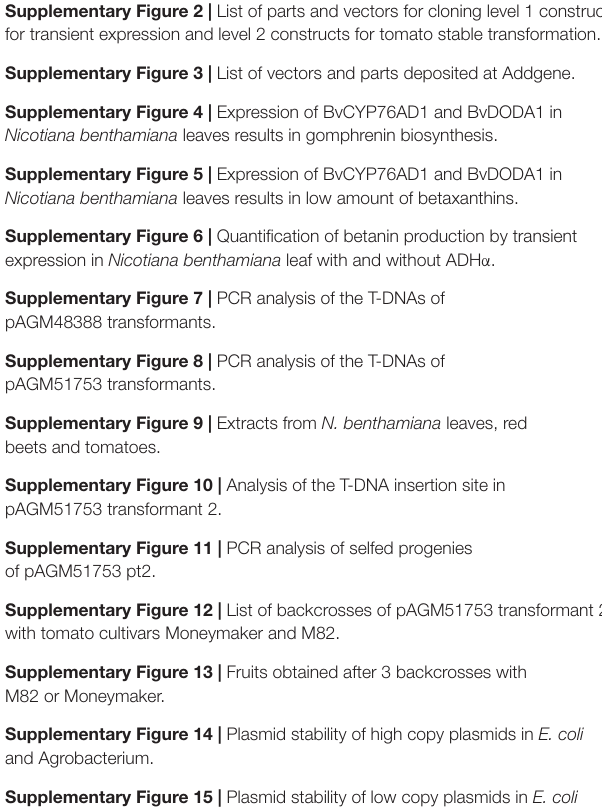
Supplementary Figure 1 | Sequence of the level 0 modules for BvCYP76AD1, BvDODA1, Db5GT, BvADH α , dTAL2, and STAP2. Supplementary Figure 2 | List of parts and vectors for cloning level 1 constructs for transient expression and level 2 constructs for tomato stable transformation. Supplementary Figure 3 | List of vectors and parts deposited at Addgene. Supplementary Figure 4 | Expression of BvCYP76AD1 and BvDODA1 in Nicotiana benthamiana leaves results in gomphrenin biosynthesis. Supplementary Figure 5 | Expression of BvCYP76AD1 and BvDODA1 in Nicotiana benthamiana leaves results in low amount of betaxanthins. Supplementary Figure 6 | Quantification of betanin production by transient expression in Nicotiana benthamiana leaf with and without ADH α . Supplementary Figure 7 | PCR analysis of the T-DNAs of pAGM48388 transformants. Supplementary Figure 8 | PCR analysis of the T-DNAs of pAGM51753 transformants. Supplementary Figure 9 | Extracts from N. benthamiana leaves, red beets and tomatoes. Supplementary Figure 10 | Analysis of the T-DNA insertion site in pAGM51753 transformant 2. Supplementary Figure 11 | PCR analysis of selfed progenies of pAGM51753 pt2. Supplementary Figure 12 | List of backcrosses of pAGM51753 transformant 2 with tomato cultivars Moneymaker and M82. Supplementary Figure 13 | Fruits obtained after 3 backcrosses with M82 or Moneymaker. Supplementary Figure 14 | Plasmid stability of high copy plasmids in E. coli and Agrobacterium. Supplementary Figure 15 | Plasmid stability of low copy plasmids in E. coli and